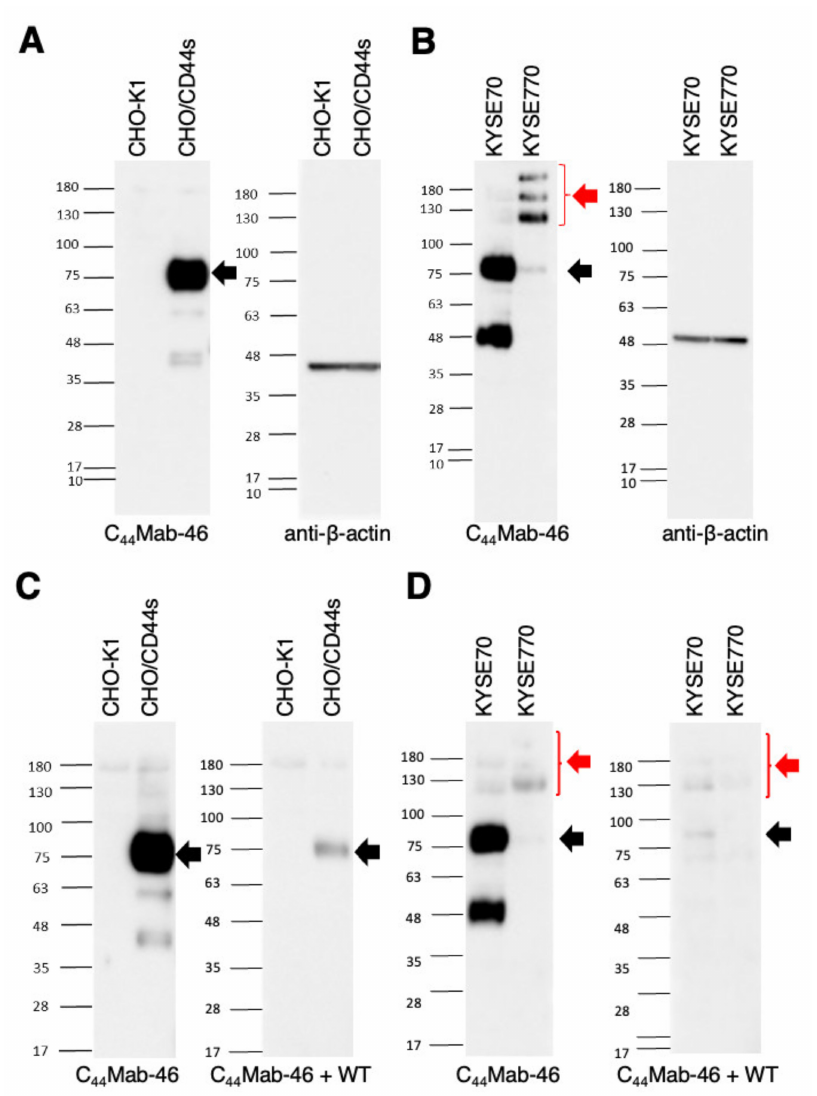
Figure 4. Western blotting by C 44 Mab − 46. ( A ) Cell lysates of CHO − K1 and CHO/CD44s (10 µ g) were electrophoresed and transferred onto polyvinylidene fluoride (PVDF) membranes. The mem- branes were incubated with 1 µ g/mL of C 44 Mab − 46 and 1 µ g/mL of anti − β − actin and subse- quently with peroxidase − conjugated anti − mouse immunoglobulins. ( B ) Cell lysates of KYSE70 and KYSE770 (10 µ g) were electrophoresed and transferred onto PVDF membranes. The membranes were incubated with 1 µ g/mL of C 44 Mab − 46 and 1 µ g/mL of anti − β − actin and subsequently with peroxidase − conjugated anti − mouse immunoglobulins. ( C ) Cell lysates of CHO − K1 and CHO/CD44s (10 µ g) were electrophoresed and transferred onto PVDF membranes. The membranes were incubated with 1 µ g/mL of C 44 Mab − 46 and C 44 Mab − 46 (1 µ g/mL) plus the CD44